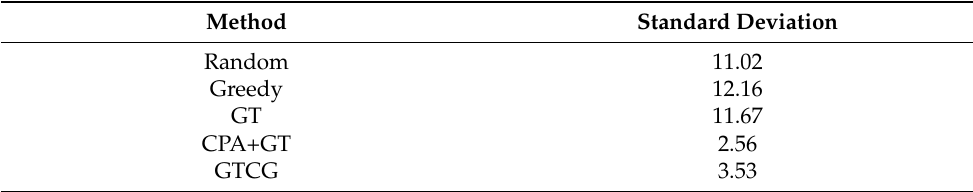
Table 1. Standard Deviation for the Number of WSDs in Different